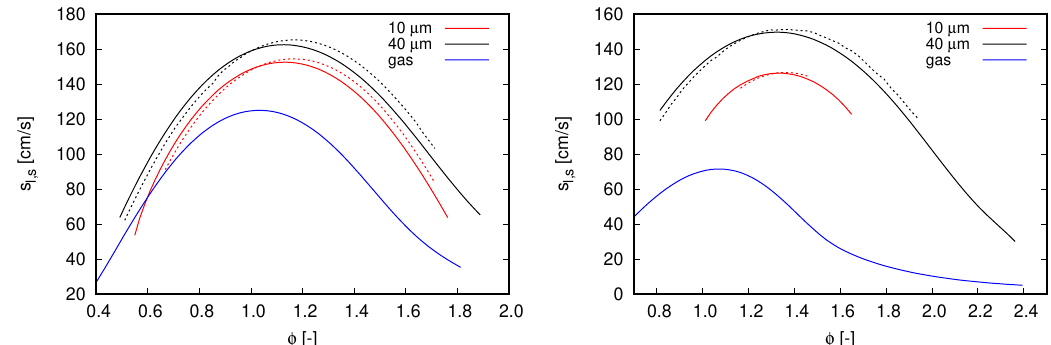
Figure 5. Flame speed computed with different mechanisms. Blue lines refer to single-phase freely propagating flames, while the remaining curves refer to flames propagating in droplet mists. Continuous lines, GRI 3.0; dash-dot lines, CRECK = 0.2; and ( right ) α = C1-C3. ( left ) α H H 2 O 2 O